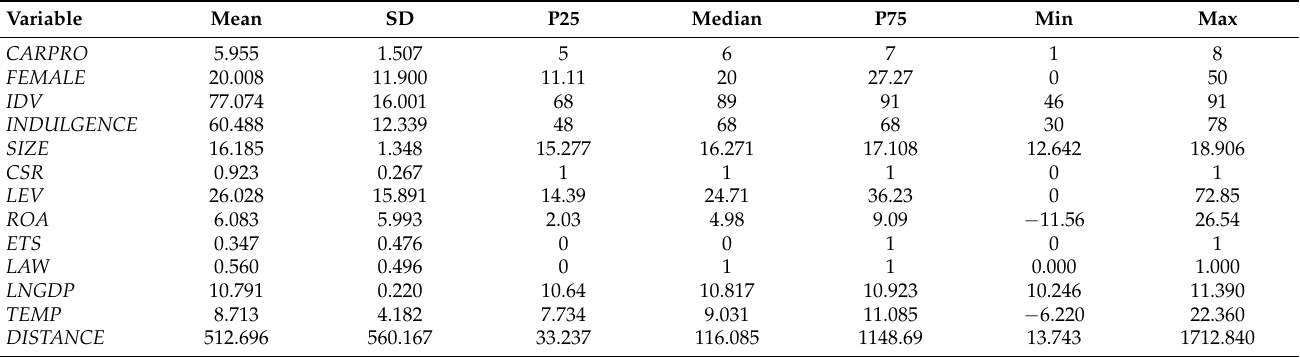
Table 3. Descriptive Statistics (N =